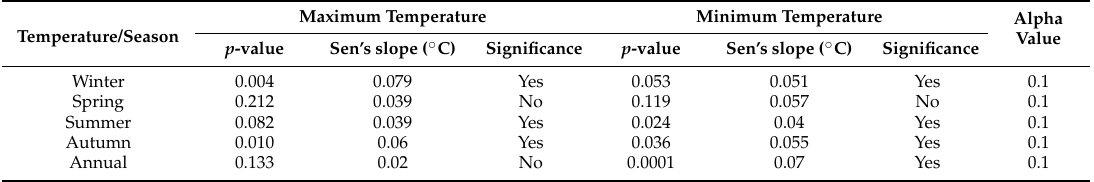
Table 4. Sen’s slope values for the seasonal and annual temperatures of the Khudi station.